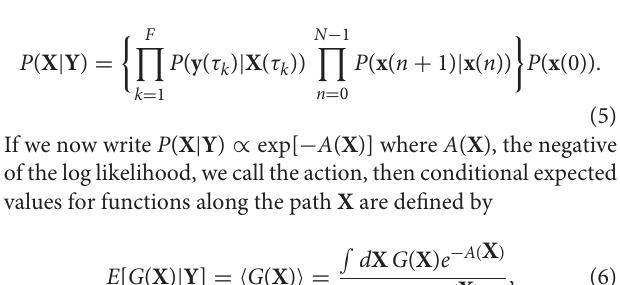
f ( x ( n ), q ) is used to move forward from time n to time 1) + = x ( F ) and the collection Y of L -dimensional observations at each = }